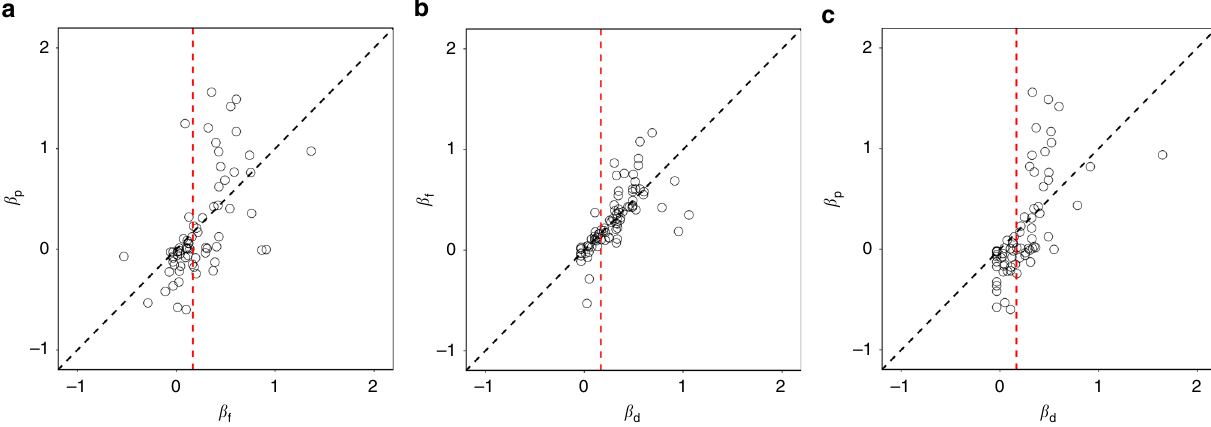
Fig. 2 Advantageous inequality aversion ( β ) under different time conditions. Higher β indicates stronger pro-sociality. Each dot represents one subject ’ s degree of pro-sociality ( β ), comparing a time-free and time-pressure conditions, b time-delay and time-free conditions, and c time-delay and time-pressure conditions. Notice that subjects to the left of the vertical red line (split by the median indifference β , sel fi sh subjects) are consistently shifted downwards while those to the right (pro-social subjects) are consistently shifted upwards. The number of subjects ( N S ) in the experiment was 102. 12 subjects whose β − 1, 2), 26 subjects whose β − 1, 2), and 8 subjects whose β − 1, 2) are not shown but were included in the f is outside of ( p is outside of ( d is outside of ( statistical analyses. The black dashed line is the identity line